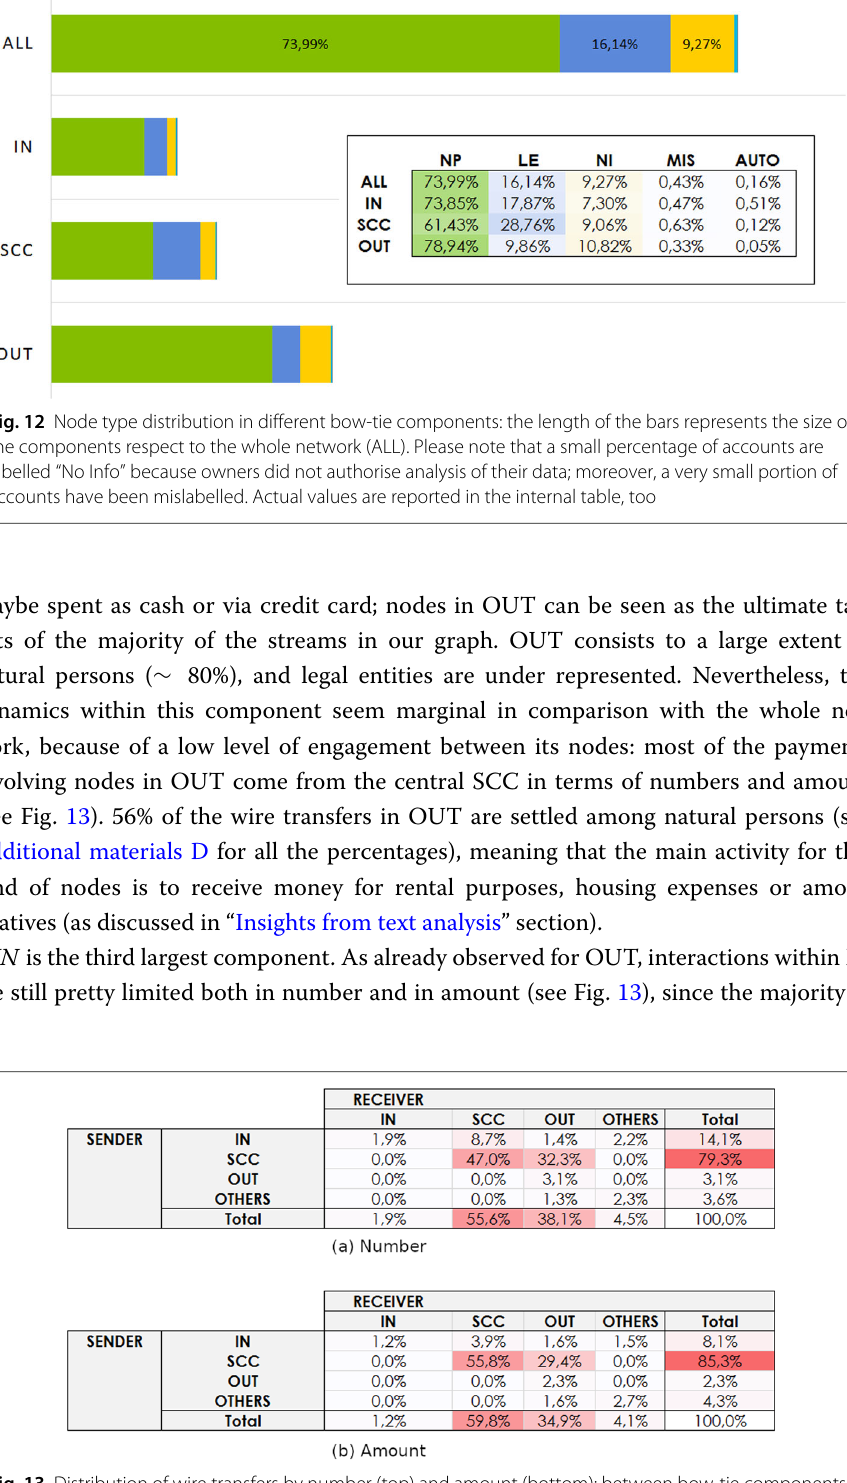
Fig. 13 Distribution of wire transfers by number (top) and amount (bottom): between bow-tie components. For each target principal components (columns) we split the contribution from all the source components (rows). The majority of wire transfers are between nodes in SCC (both by amount and